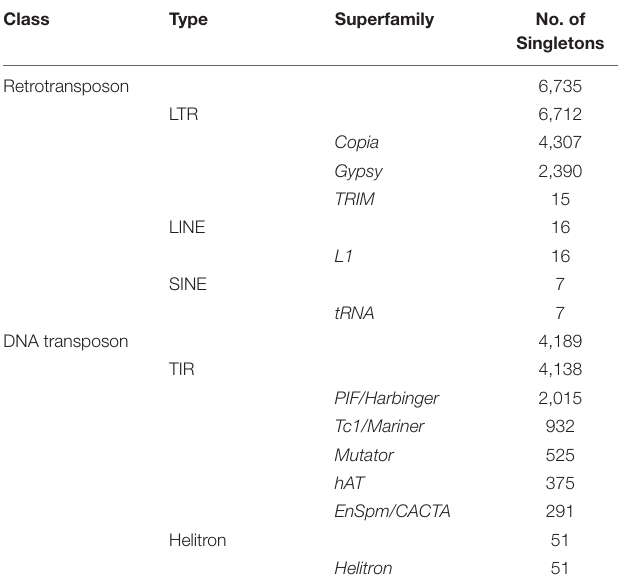
TABLE 1 | The classification of 10,924 singletons identified from 3,000 natural rice accessions.